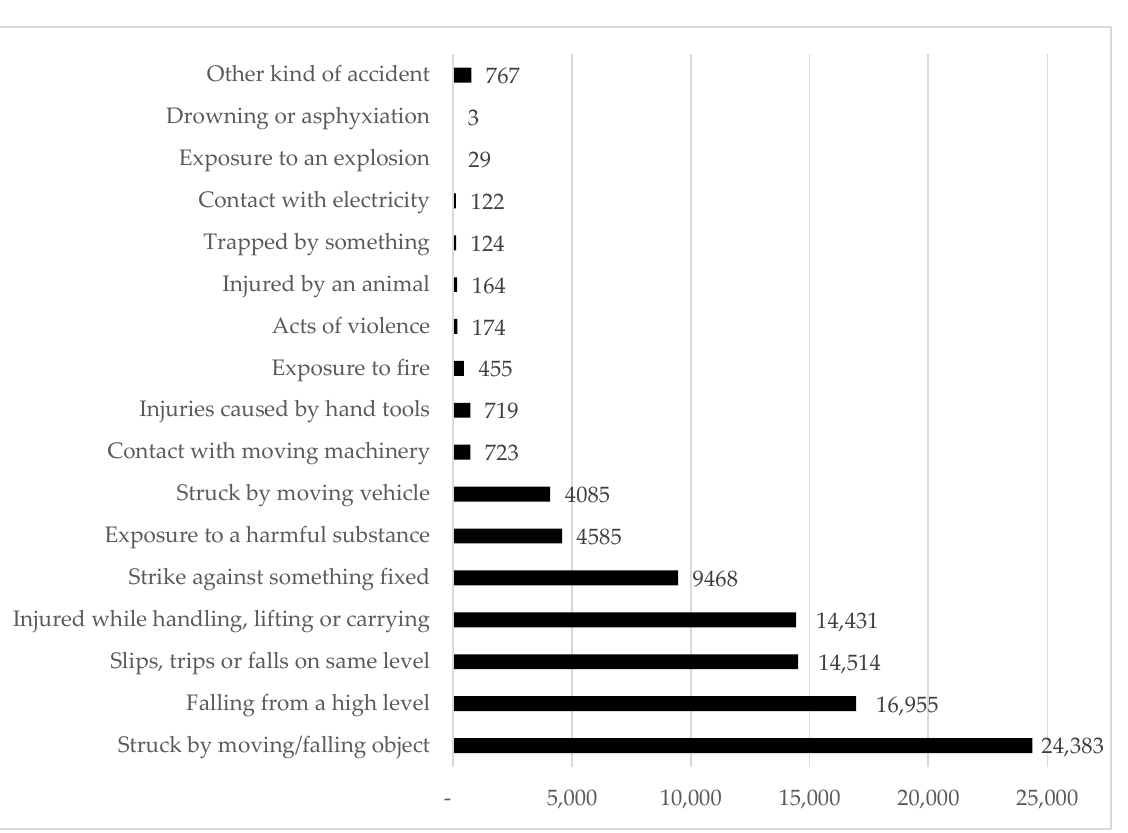
Figure 1. Total number of construction accidents by type in one year combined in the US, UK, and Israel [35].